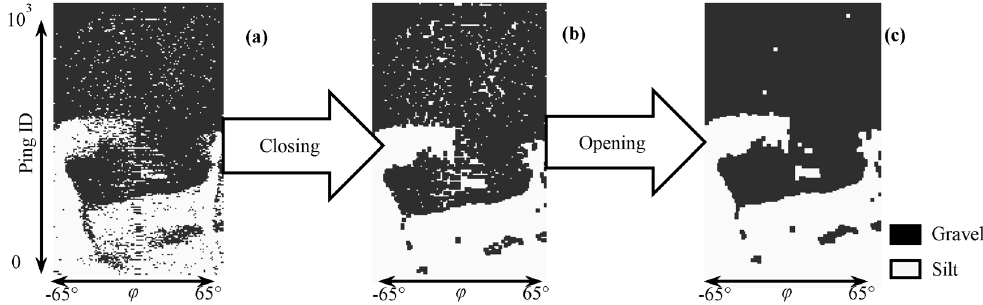
Figure 5. Denoising of MBES sediment image. ( a ) Original classification image; ( b ) image after eliminating noise by closing; and ( c ) image after connecting the main sediment by opening of (b). φ is the incident angle.